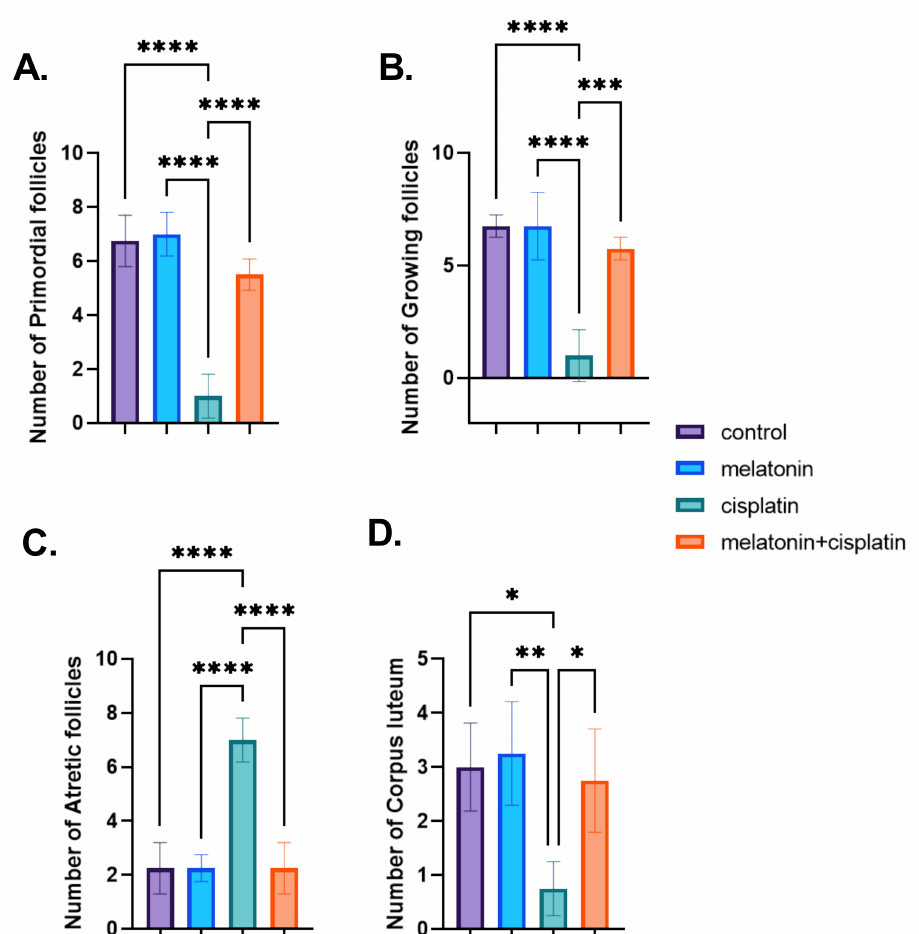
Figure 8. Effect of melatonin administration in cisplatin-induced ovarian impairment in female rats on ovarian follicles counting ( A – D ). ( A ) The number of primordial follicles, ( B ) number of growing follicles, ( C ) number of atretic follicles, and ( D ) number of corpus luteum. Data are expressed as means ± SEM. n = 8. *, **, ***, **** indicate significant difference ( p < 0.05, p < 0.01, p < 0.001, and p <